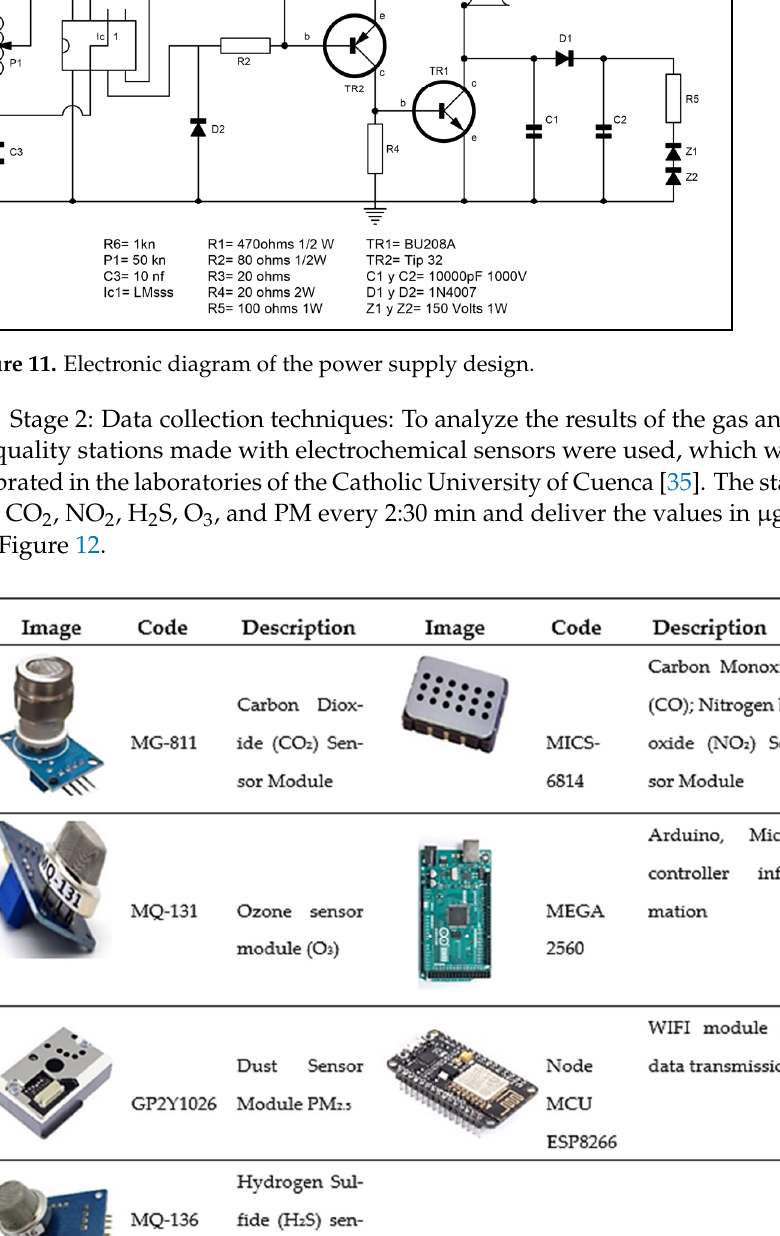
Figure 10. Prototype lattice construction.